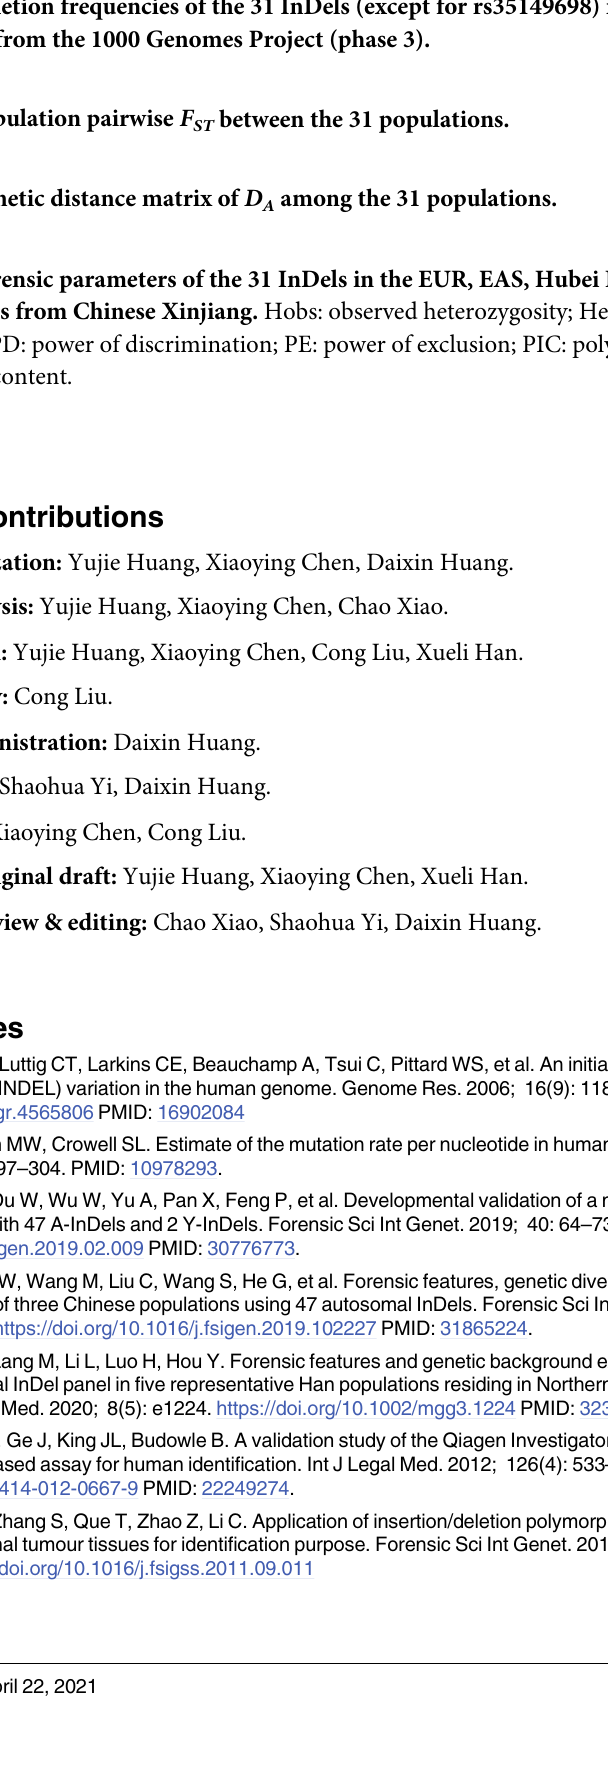
S3 Table. Deletion frequencies of the 31 InDels (except for rs35149698) in the 26 reference populations from the 1000 Genomes Project (phase 3). S4 Table. Population pairwise F between the 31 populations. ST S5 Table. Genetic distance matrix of D among the 31 populations. A S6 Table. Forensic parameters of the 31 InDels in the EUR, EAS, Hubei Han and four eth- nic minorities from Chinese Xinjiang. Hobs: observed heterozygosity; Hexp: expected het- erozygosity; PD: power of discrimination; PE: power of exclusion; PIC: polymorphic information